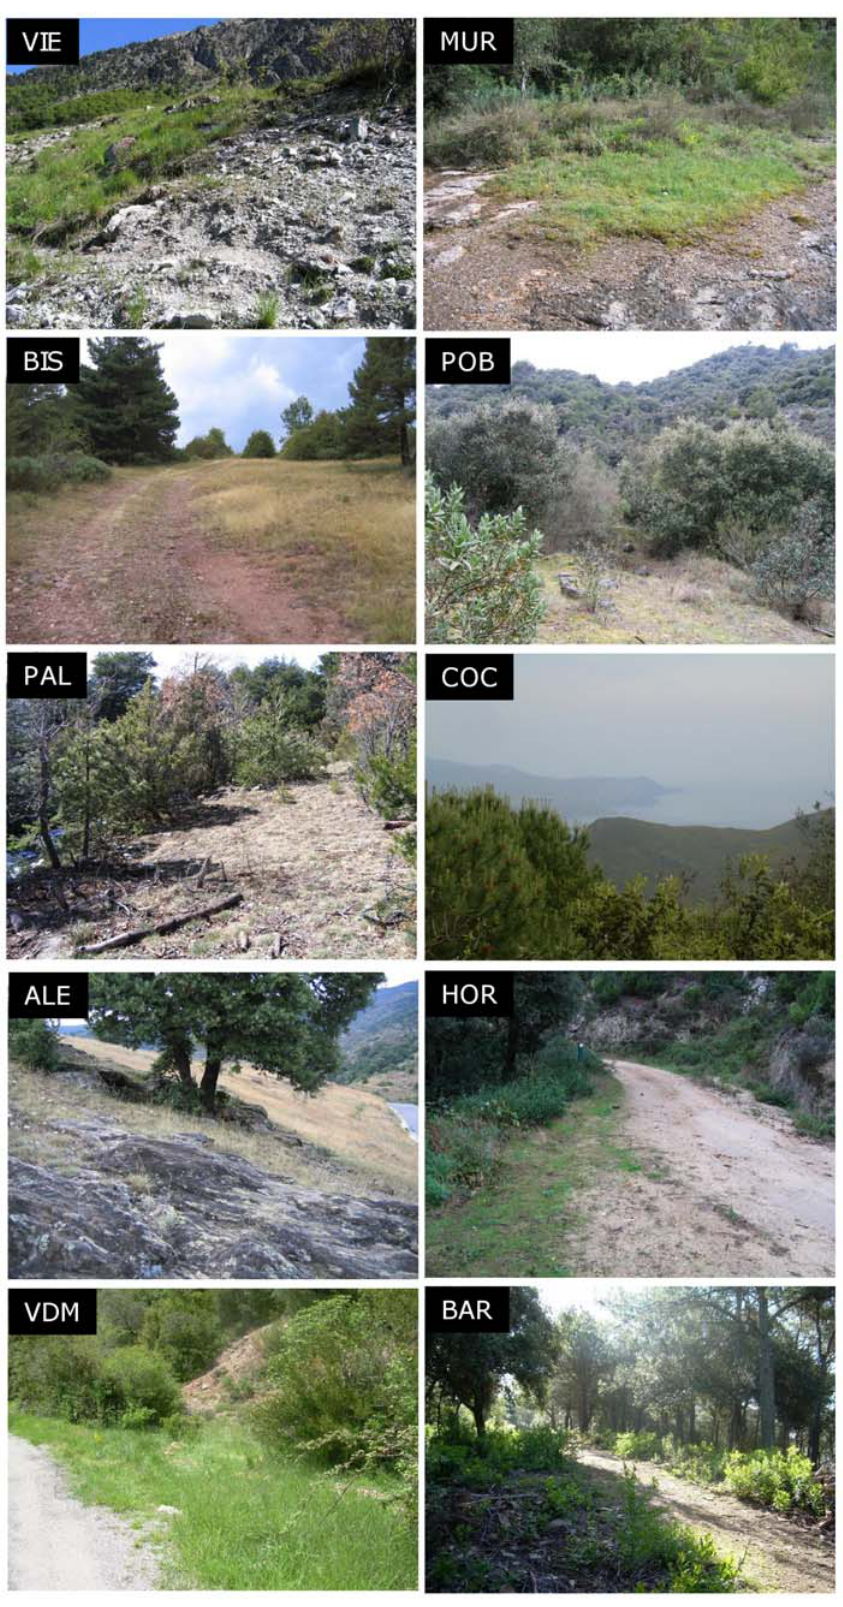
Figure 2. Photographs of study populations. The photographs show the habitat type and the area where permanent plots were laid down. Left and right panels are montane and coastal populations, respectively. Populations are ranked according to their altitude within each region.